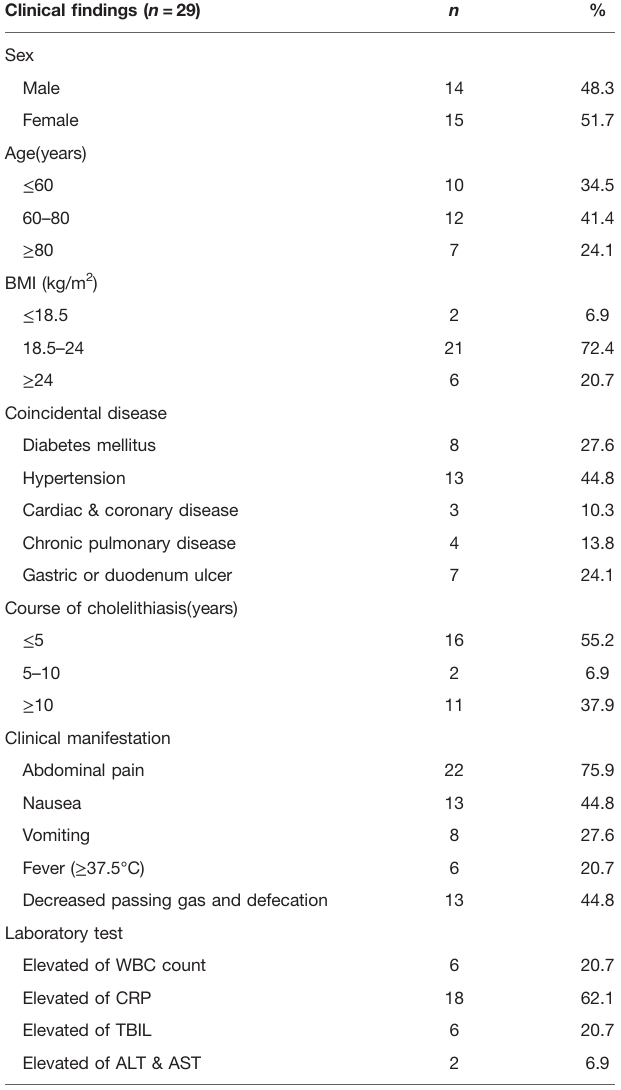
TABLE 1 | Basic clinical dates of CEF with and without GI. Clinical fi ndings ( n